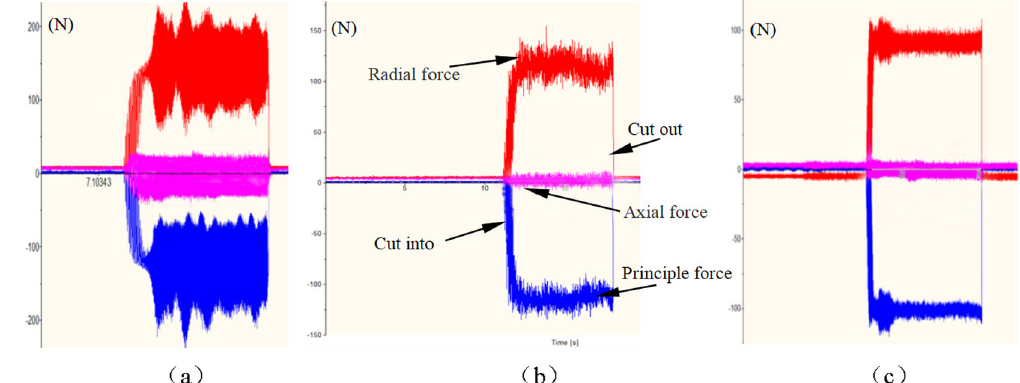
Figure 3: Comparison of three - direction cutting forces. ( a ) YT5, ( b ) PT4, ( c )